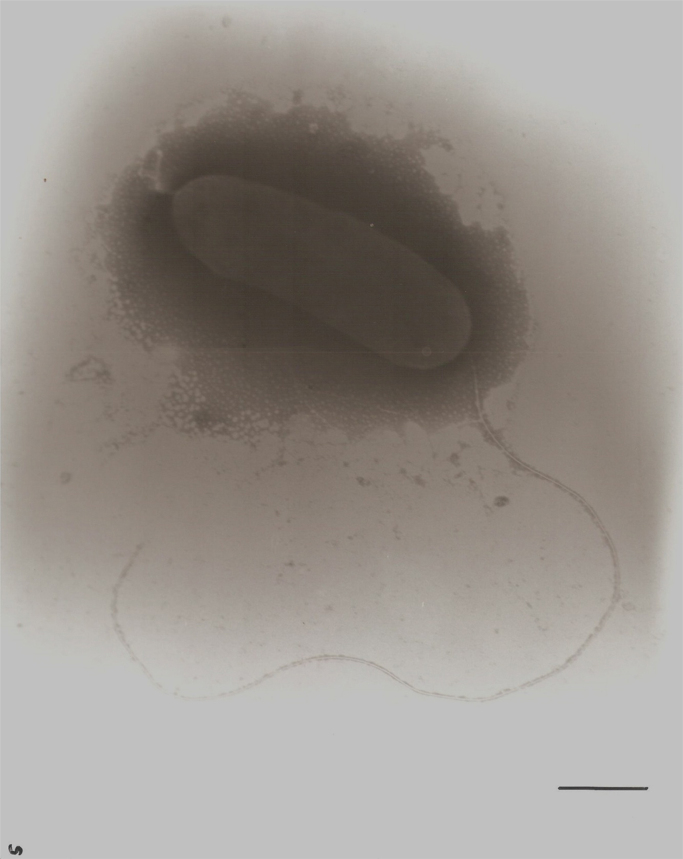
Transmission electron micrograph of negatively-stained S. olleyana showing a single polar flagellum (F). Bar, 0.5 μm.